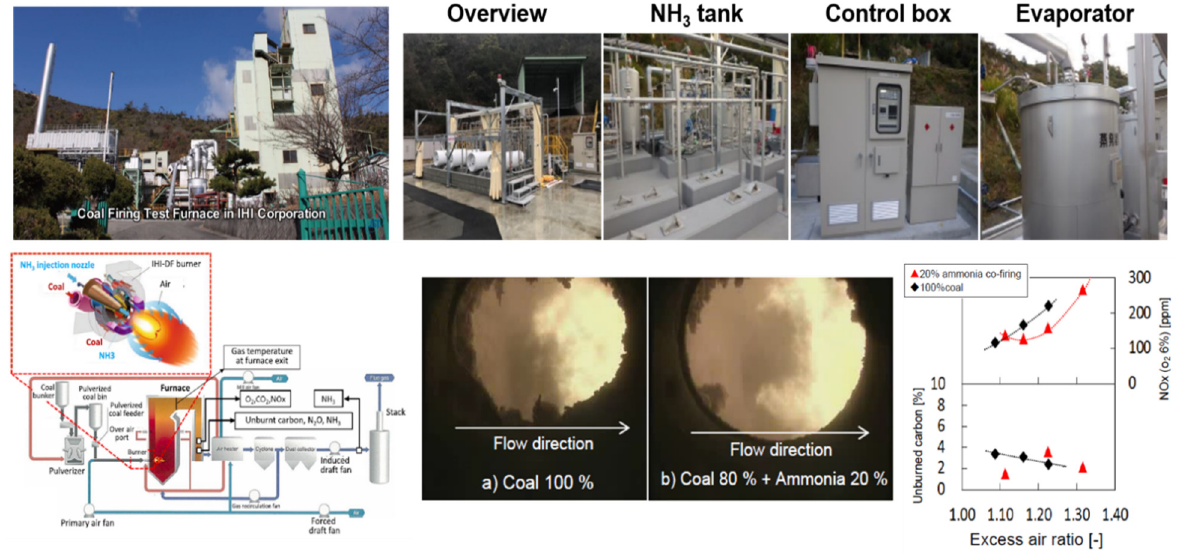
Figure 26. Coal firing test furnace and NH 3 feeding facilities in IHI. Modified from [116]. Courtesy of Ammonia Energy Association [116].